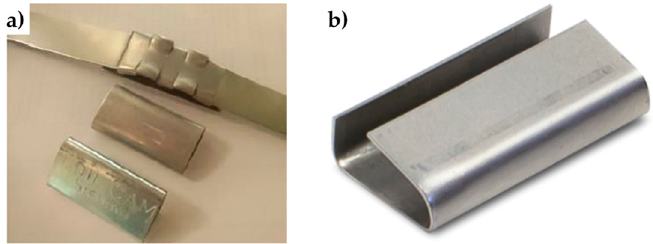
Figure 25. Sealing system of the patented CAM system: ( a ) steel ribbons and seals [11] and ( b ) a detail of a CAM seal.